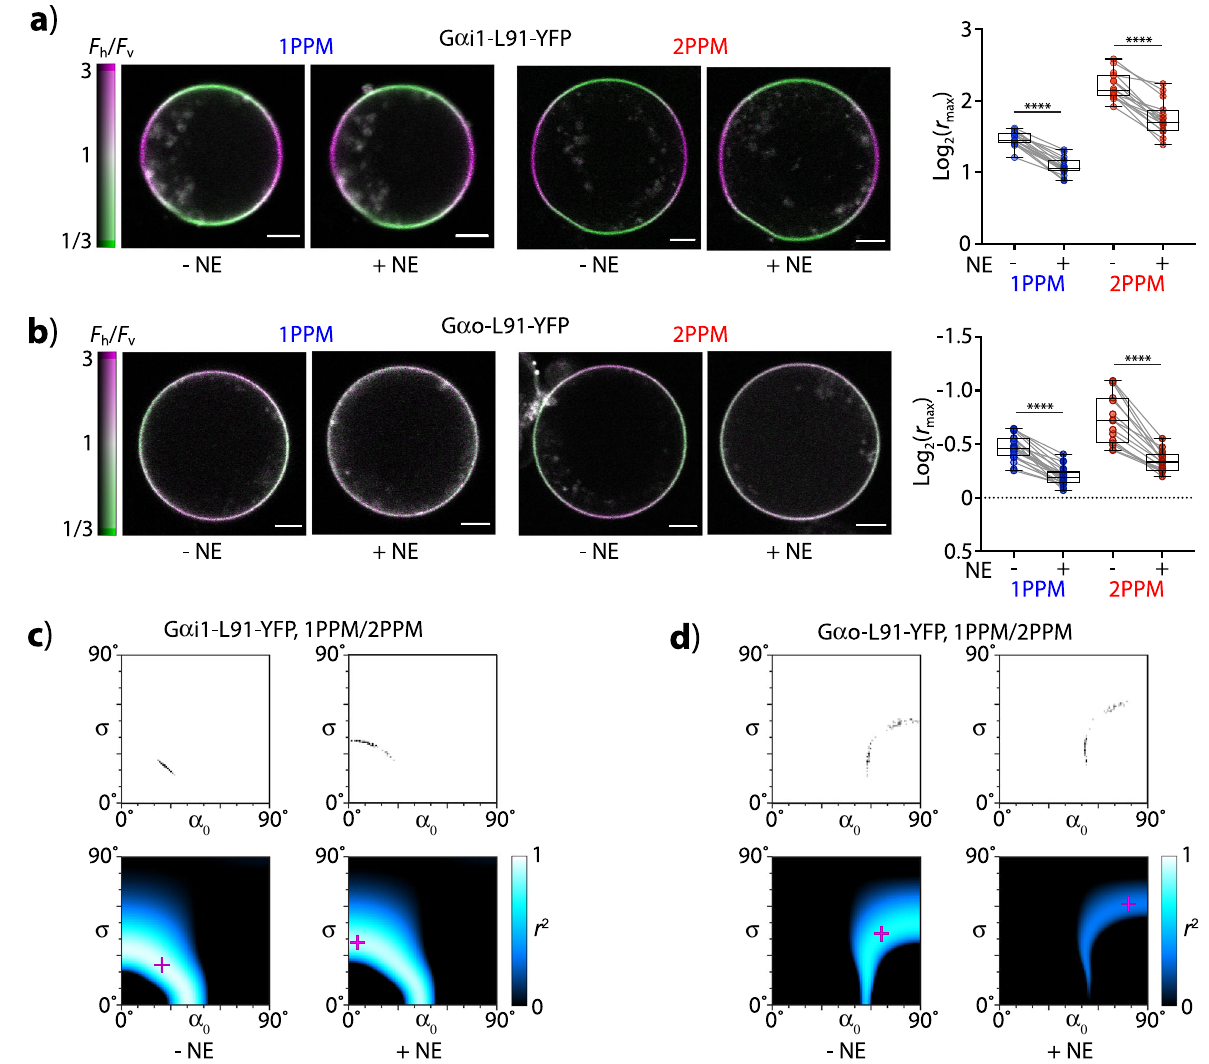
Fig. 7 Changes in orientation of fl uorescently labeled G-protein constructs during activation of the G-protein signaling pathway. a LD of round cells expressing G α i1-L91-eYFP. Left: representative images acquired by 1PPM and 2PPM, before and after activation by norepinephrine (NE). Images are colored according to LD, as indicated by the color bar. Scale bar: 20 µ m. Right: changes in LD upon activation by NE. Median values, 25th and 75th percentiles, and ranges are shown. Asterisks (****) indicate statistically signi fi cant difference, with P value smaller than 0.0001. b Same as ( a ), but for G α o-L91-eYFP. c Combinations of α 0 , σ values consistent with pooled 1PPM and 2PPM observations of cells expressing G α i1-L91-eYFP, before and after activation. Top: estimate of 95% con fi dence interval obtained by bootstrapping. Bottom: Heat-map of goodness of fi t (expressed as r 2 ) of combined 1PPM/2PPM data, for different distributions of molecular orientations (described by values of α 0 , σ ). The α 0 , σ combination in best agreement with microscopy data is indicated by a magenta cross. d Same as ( c ), but for G α